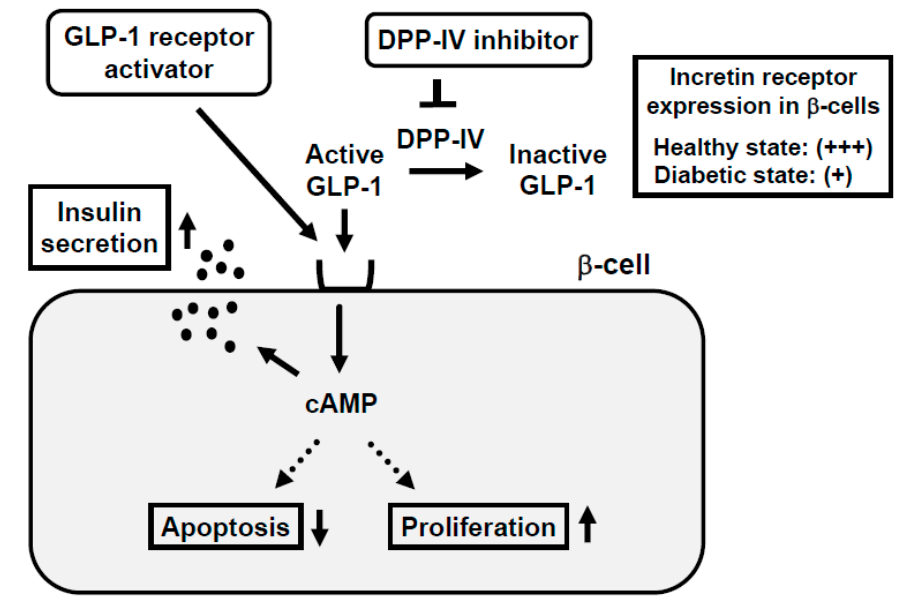
Figure 2. Mechanism of action of incretin and incretin-based agents in pancreatic β -cells and reduced expression of incretin receptor in β -cells in a diabetic state. Binding of incretin to incretin receptor in β -cell membrane increases intracellular cAMP levels, which finally leads to augmentation of insulin secretion from β -cells, reduction of β -cell apoptosis, and facilitation of β -cell proliferation. In a healthy state, the incretin receptor is abundantly expressed in the β -cell membrane, but in a diabetic state, the incretin receptor expression is substantially reduced.